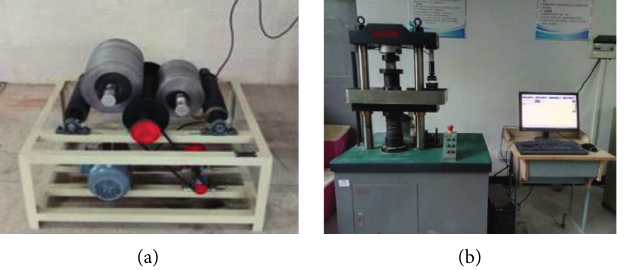
Figure 3: Instruments used in the study. (a) The ball mill of the WZM-15 × 2 model. (b) Cement gel sand bending compression testing